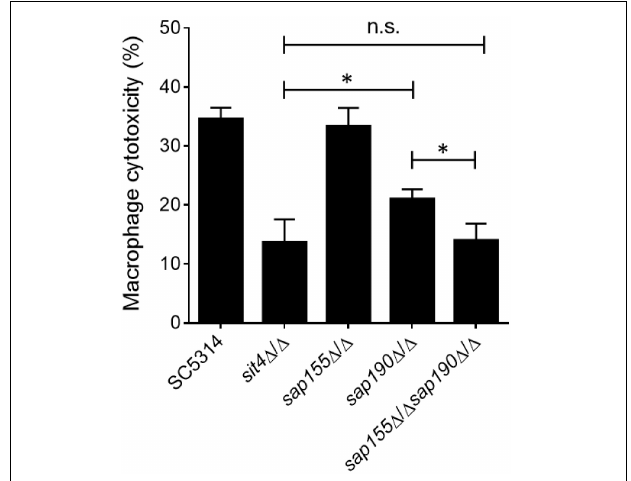
FIGURE 5 | The ability of sit4 (cid:49) / (cid:49) , sap155 (cid:49) / (cid:49) , sap190 (cid:49) / (cid:49) , and sap155 (cid:49) / (cid:49) sap190 (cid:49) / (cid:49) mutants to damage macrophages in vitro . Yeast cultures of SC5314, sit4 (cid:49) / (cid:49) , sap155 (cid:49) / (cid:49) , sap190 (cid:49) / (cid:49) , and sap155 (cid:49) / (cid:49) sap190 (cid:49) / (cid:49) strains were co-cultured with RAW264.7 macrophages for 5 h. Cytotoxicity was determined using an LDH release assay. Results are the mean ± SD of three independent experiments, each performed in triplicates. The results were analyzed with Student’s t -test. ∗ p < 0.05 compared between the indicated two groups. n.s.: no significance.